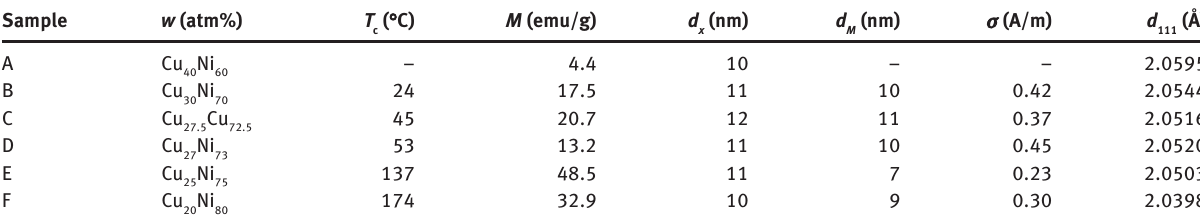
, magnetization M , average particle size from X-ray diffraction d c , standard deviation σ , and d M